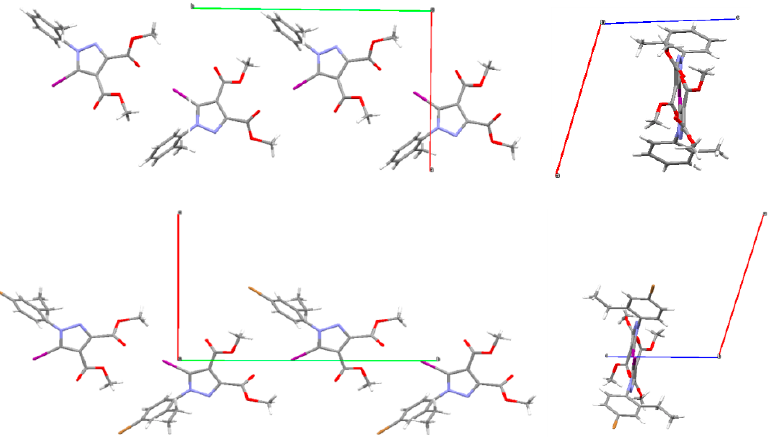
Figure 16. Infinite chains generated by the C-I ··· O interactions along the b-axis (green colour) in 1 ( top ) and 4 ( bottom ) showing similar crystal packing.